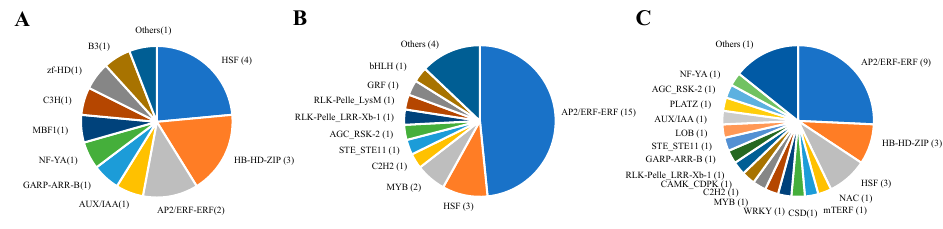
Figure 6. Classification of differently expressed TFs in comparisons of ( A ) GNo.45 vs. NG, ( B ) GNo.96 vs. NG, and ( C ) GNo.45 vs. GNo.96.